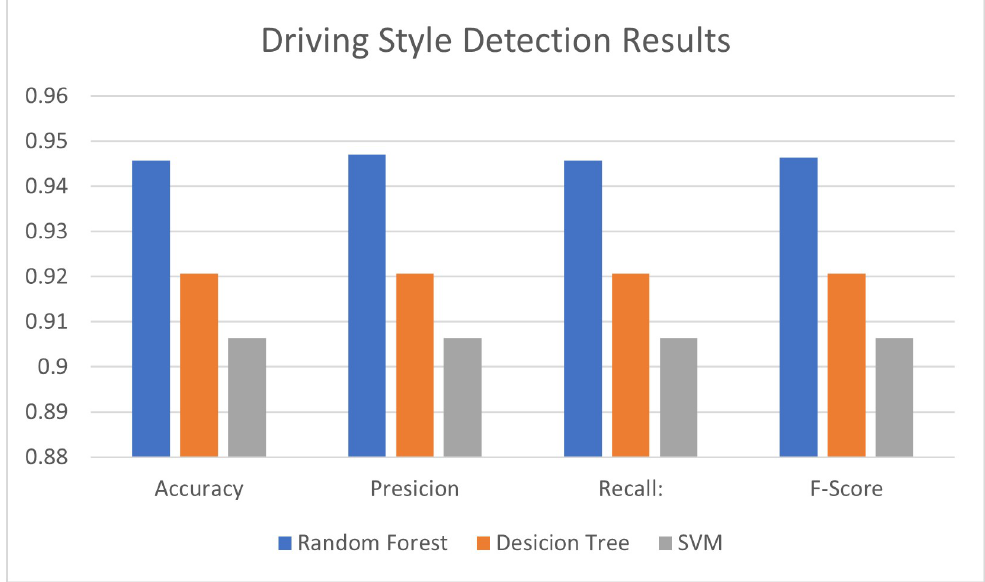
Figure 5. Accuracy, precision, recall and F-score for driving style